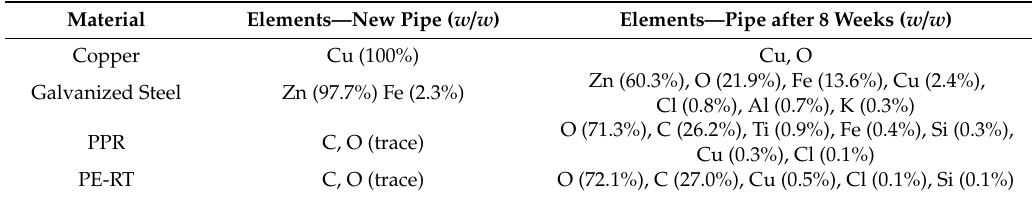
Table 1. Energy dispersive spectrometer (EDS) analyses on